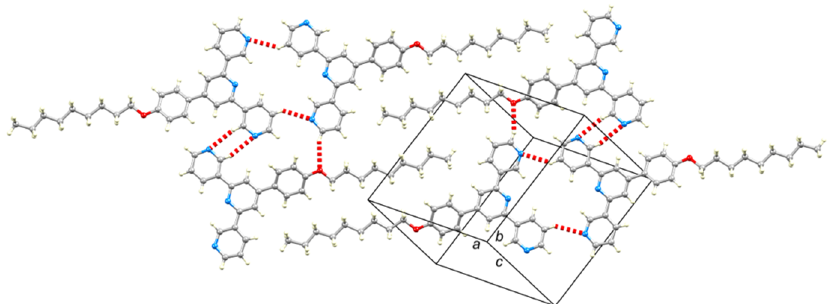
Figure 9. ( a ) O ff set face-to-face π -stacking of two crystallographically independent molecules of Figure 9. ( a ) Offset face-to-face  -stacking of two crystallographically independent molecules of 9 . ( b ) 9 . ( b ) Packing of molecules of 9 into 2D-layers with the π -stacking shown in ( a ) highlighted in Packing of molecules of 9 into 2D-layers with the  -stacking shown in ( a ) highlighted in space-filling Molecules 2020 , 25 , x FOR PEER REVIEW space-filling representation. representation.